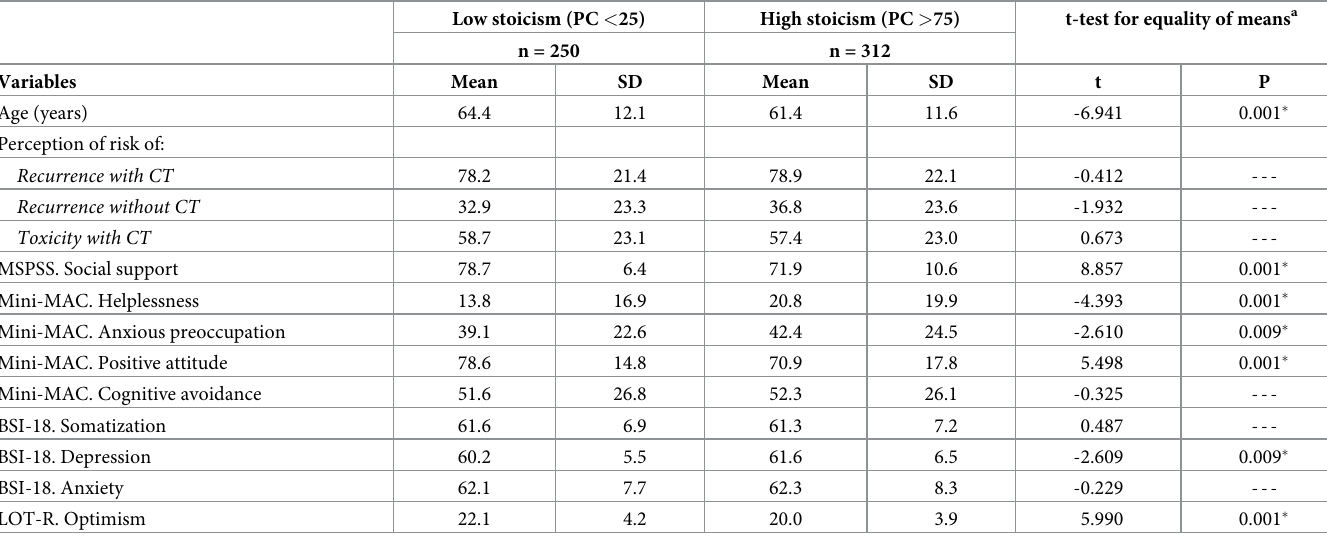
Table 3. Comparison of cancer patients with high and low stoicism by age, perception of risk of recurrence and toxicity, and psychological